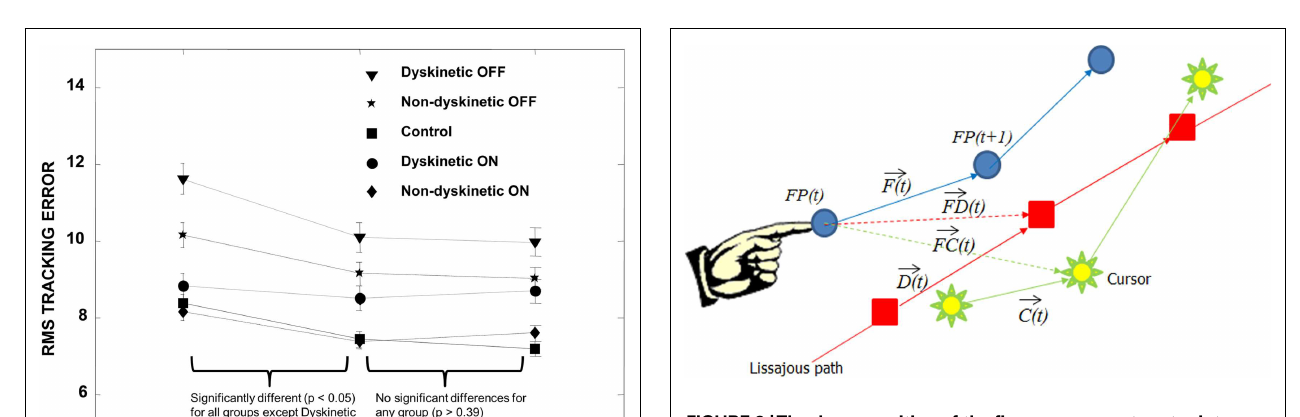
FIGURE 2 |The decomposition of the finger movement vector into different constituent vectors .The blue arrow represents the finger velocity [(cid:69) F ( t ) ] , the green arrow the cursor velocity [(cid:69) C ( t ) ] , the red arrow the desired velocity [(cid:69) D ( t ) ] , the green dotted arrow from the finger position to the cursor [ (cid:69) FC ( t )], and the red dotted arrow represents the vector from the finger to the desired point [ (cid:69) FD ( t